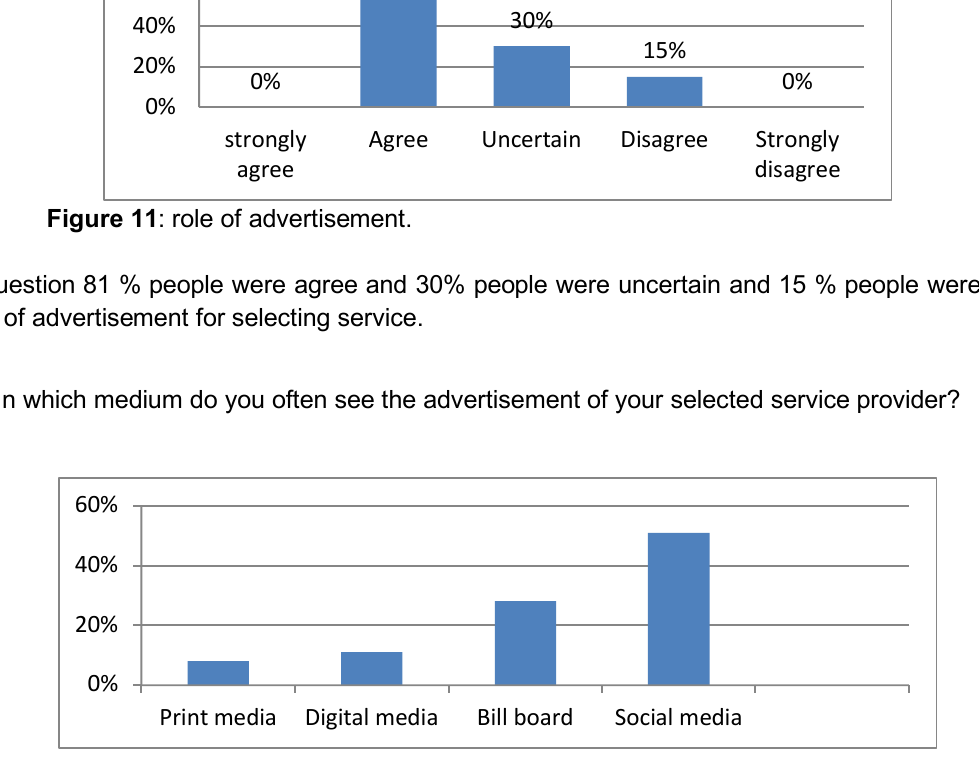
Figure12 : the advertisement of your selected service